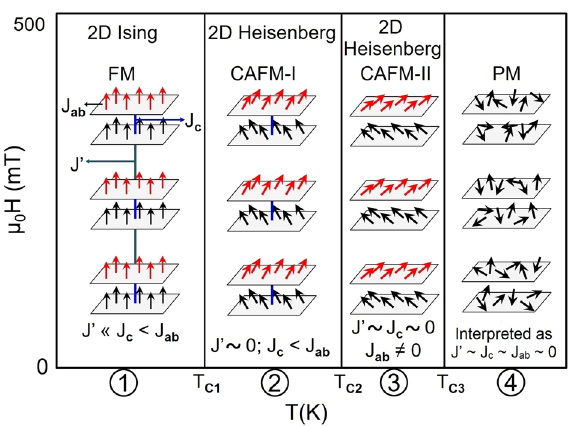
Figure 14. Schematic magnetic phase diagram: below T C 1 , there exists high magnetic anisotropy normal to the plane of bilayer and behaving as 2D Ising FM. In between T C 1 and T C 2 the behavior is changed to (CAFM-I) with 2D Heisenberg interaction. For T C 2 < T < T C 3 the behavior is further changed to higher canting (CAFM-II) with 2D Heisenberg interaction and no interaction between planes of bilayer. Finally above T C 3 , spins become independent and the entire sample behaves as